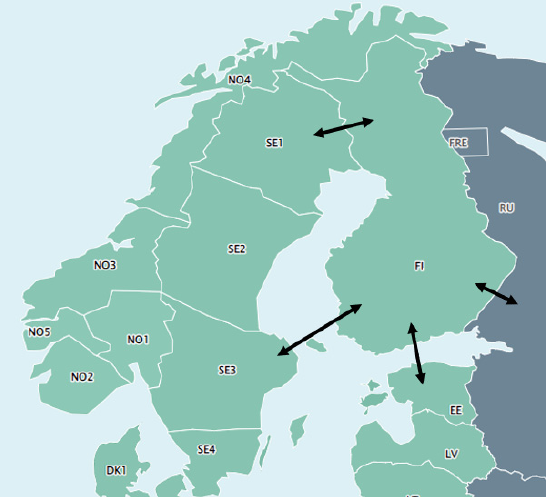
Figure 3. Finland and its connections to its neighbouring market areas.